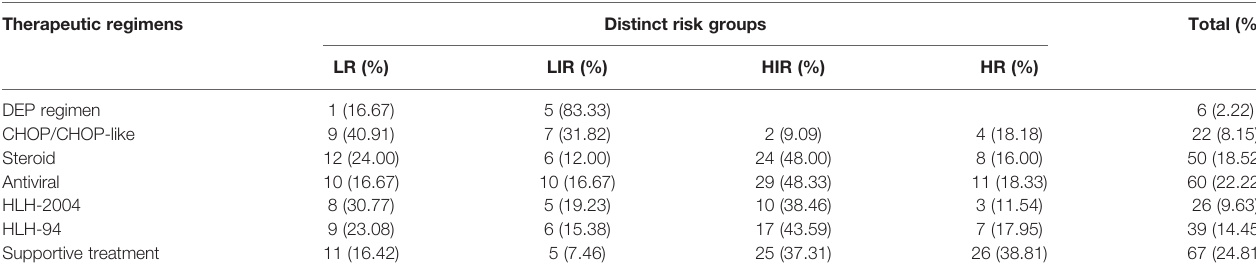
TABLE 4 | Distribution of patients in different therapeutic regimens groups. Therapeutic regimens Distinct risk